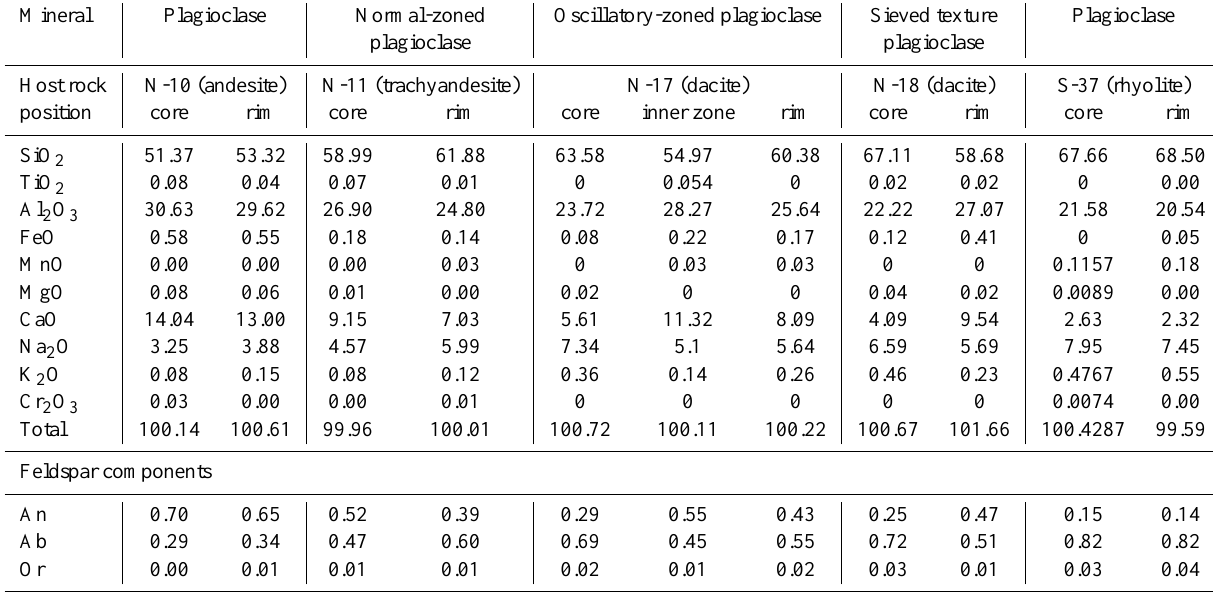
Table 3. Representative compositions of plagioclases from post-ophiolite rocks in Sabzevar zone. Mineral Plagioclase Normal-zoned Oscillatory-zoned plagioclase Sieved texture